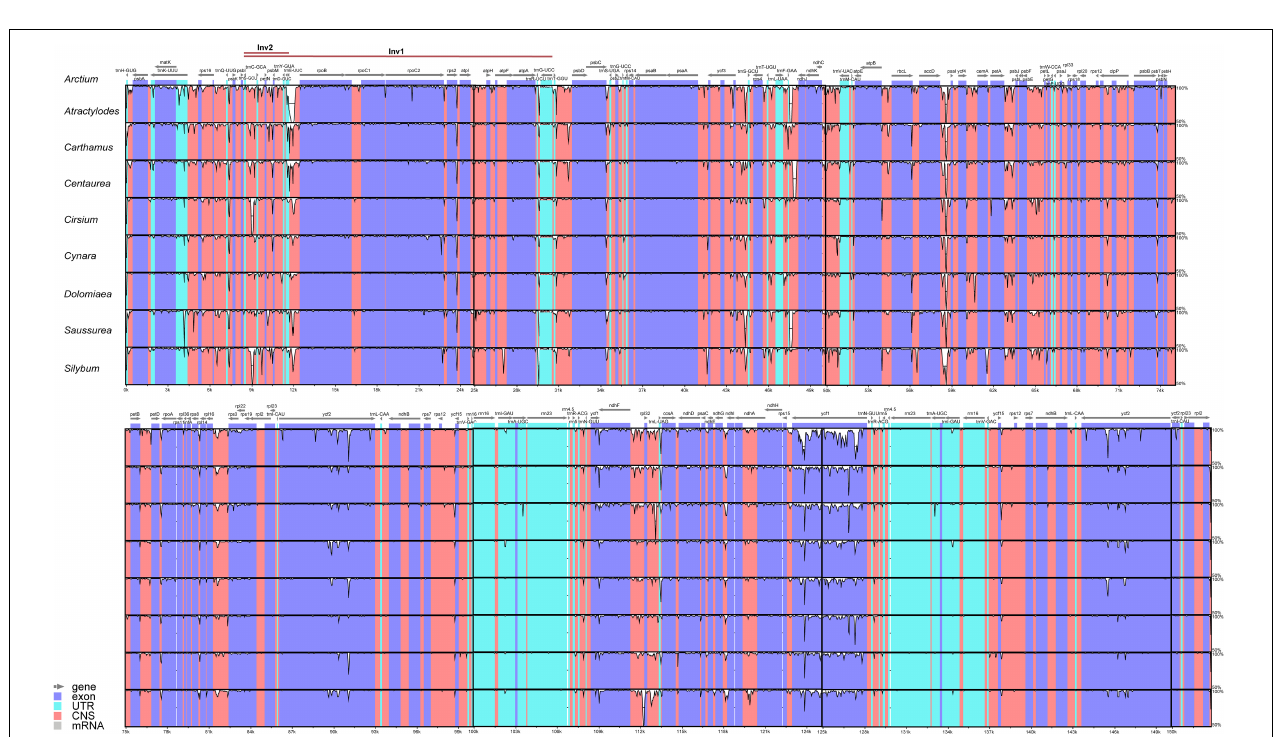
FIGURE 2 | Comparison of IR-SC border positions across plastomes of four Dolomiaea species and Saussurea japonica . Genes are denoted by colored boxes. The gaps between the genes and the boundaries are indicated by the base lengths (bp).